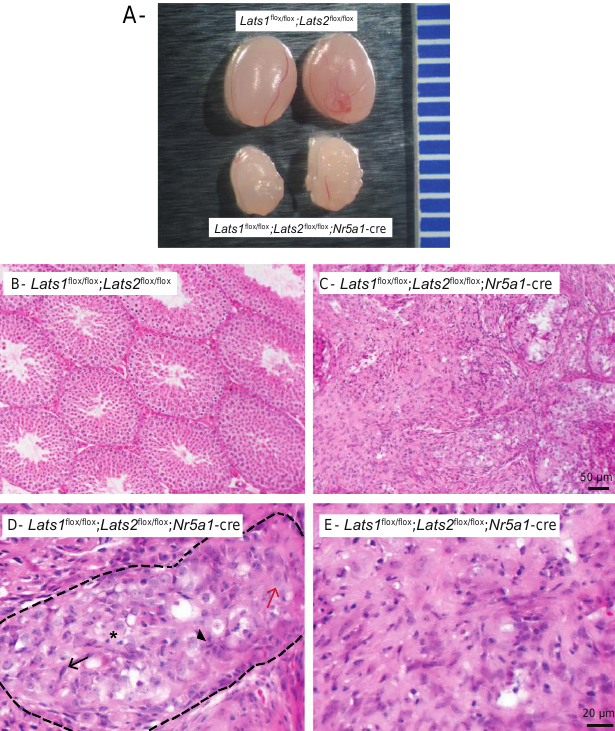
Figure 1. Testes of Lats1 flox/flox ; Lats2 flox/flox ; Nr5a1 -cre mice are larger than controls and are histomorphologically abnormal. ( A ) Photographs of testes from 2-week-old Lats1 flox/flox ; Lats2 flox/flox (control) and Lats1 flox/flox ; Lats2 flox/flox ; Nr5a1 -cre mice. Ruler graduations are in millimeters. ( B , C ) Photomicrographs comparing the testes of 2-week-old ( B ) Lats1 flox/flox ; Lats2 flox/flox and ( C ) Lats1 flox/flox ; Lats2 flox/flox ; Nr5a1 -cre mice. ( D , E ) Photomicrographs illustrating the remaining seminiferous tubules ( D ) and interstitium ( E ) in Lats1 flox/flox ; Lats2 flox/flox ; Nr5a1 -cre mice at higher magnification. Arrowhead = cells with a large nucleus and pale abundant cytoplasm. Red arrow = cell with an elongated large nucleus with an abundant cytoplasm. Black arrow = spindle-shaped cells. Asterisk = pyknotic cell. Dashes = delimitation of the seminiferous tubules. Scale bar in C is valid for B and scale bar in E is valid for D. Hematoxylin and eosin stain.